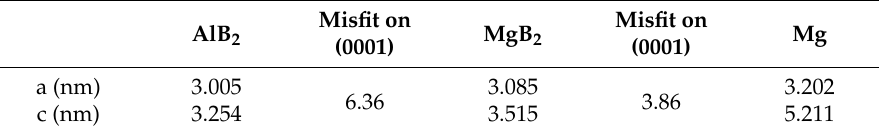
Table 6. Lattice parameters and misfit of AlB 2 , MgB 2 and Mg.